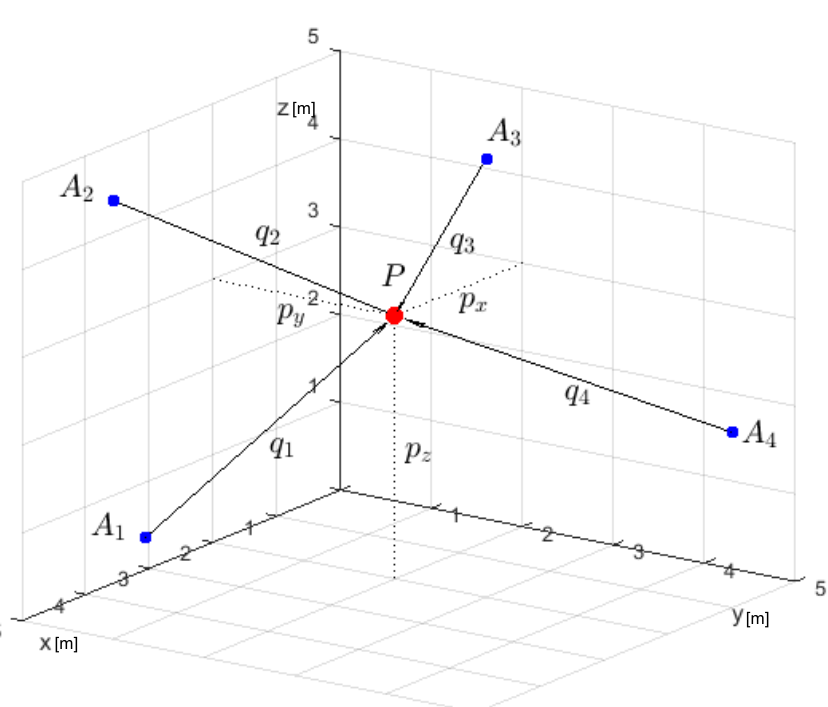
Figure 2. Placement of the anchors in the reference